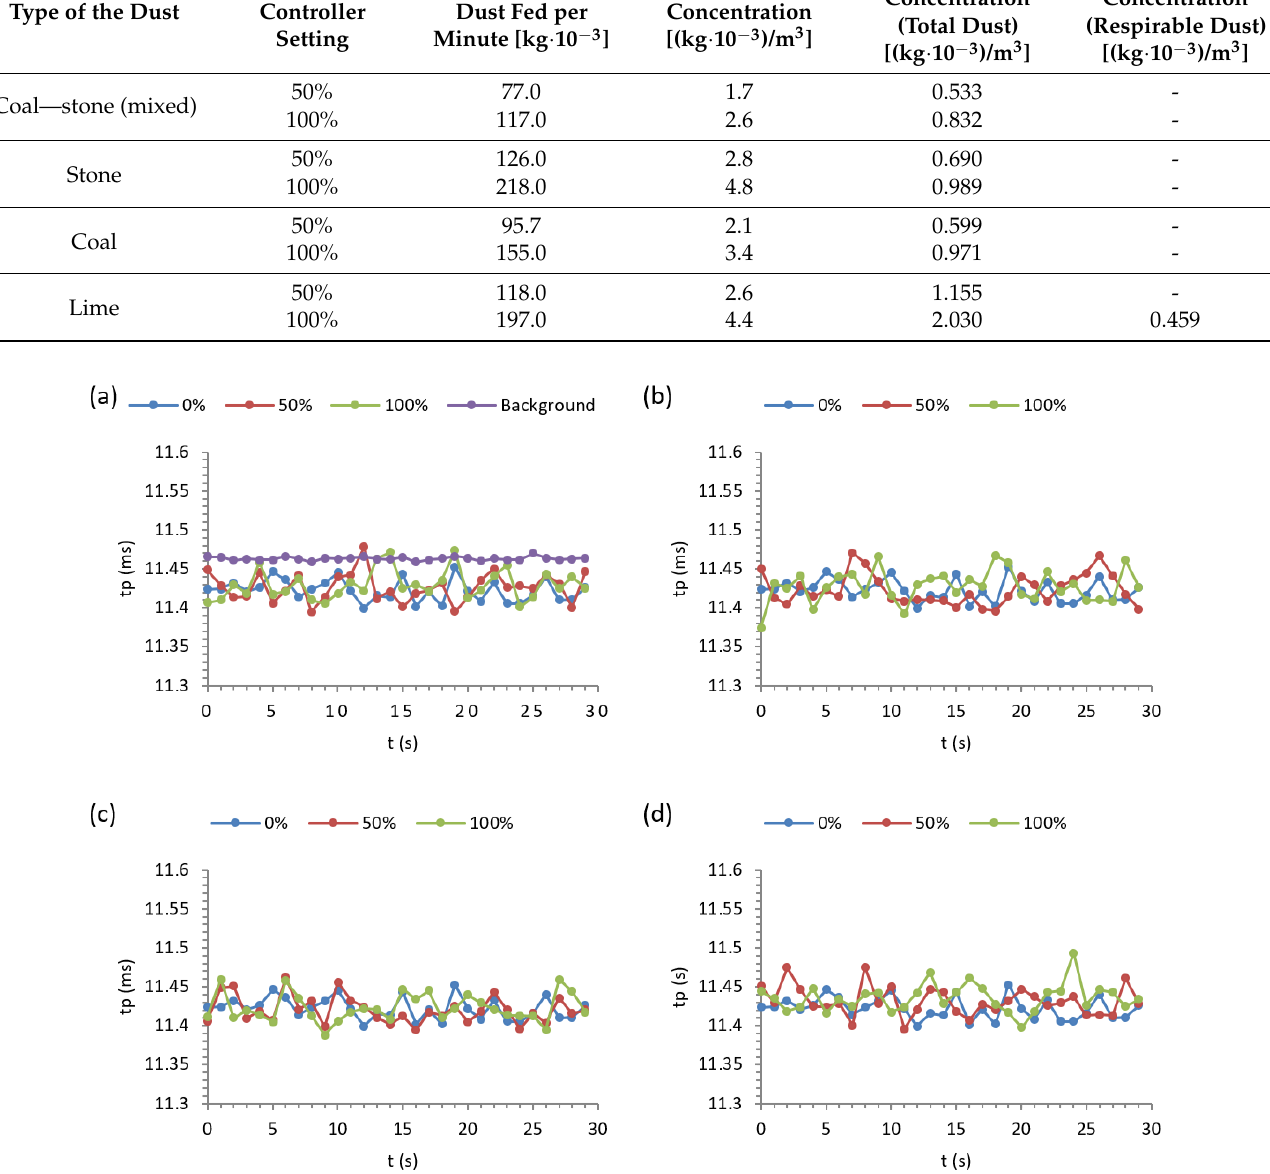
Figure 6. Graphs of the ultrasonic wave propagation time (AR41), with the propagation direction following the airflow direction: ( a ) coal dust, ( b ) stone dust, ( c ) coal-stone dust, ( d ) limestone dust.